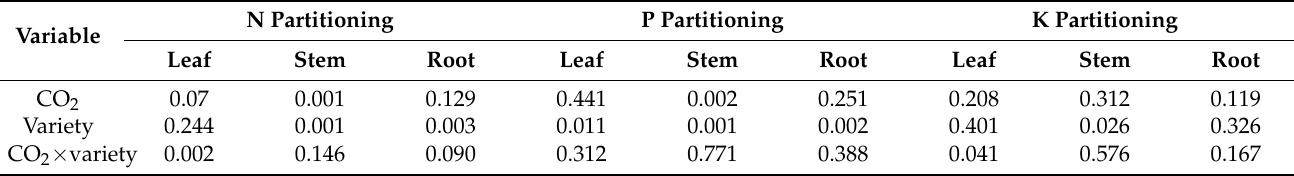
Table 2. Results of two-way ANOVA for the main effects and factor interactions between varieties and CO 2 on N, P and K partitioning in different plant tissues of two mulberry varieties ( Morus multicaulis Perr. var. QiangSang and NongSang) grown under ambient CO 2 (ACO 2 , 410/460 ppm, daytime/nighttime) and elevated CO 2 (eCO 2 , 710/760 ppm) levels. N Partitioning P Partitioning K Partitioning Variable Leaf Stem Root Leaf Stem Root Leaf